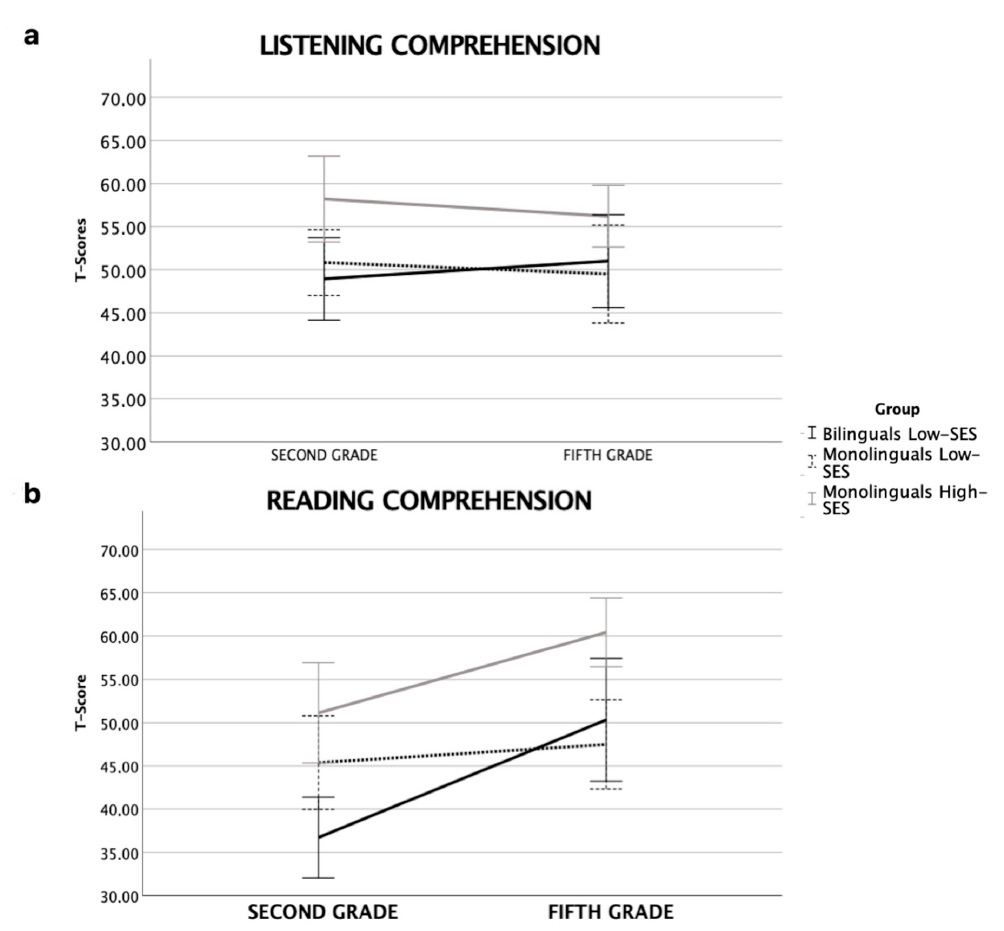
Figure 2. Line bars representing listening ( a ) and reading comprehension ( b ) performance (T-scores) in second and fifth grade for the three groups (error bars: 95%